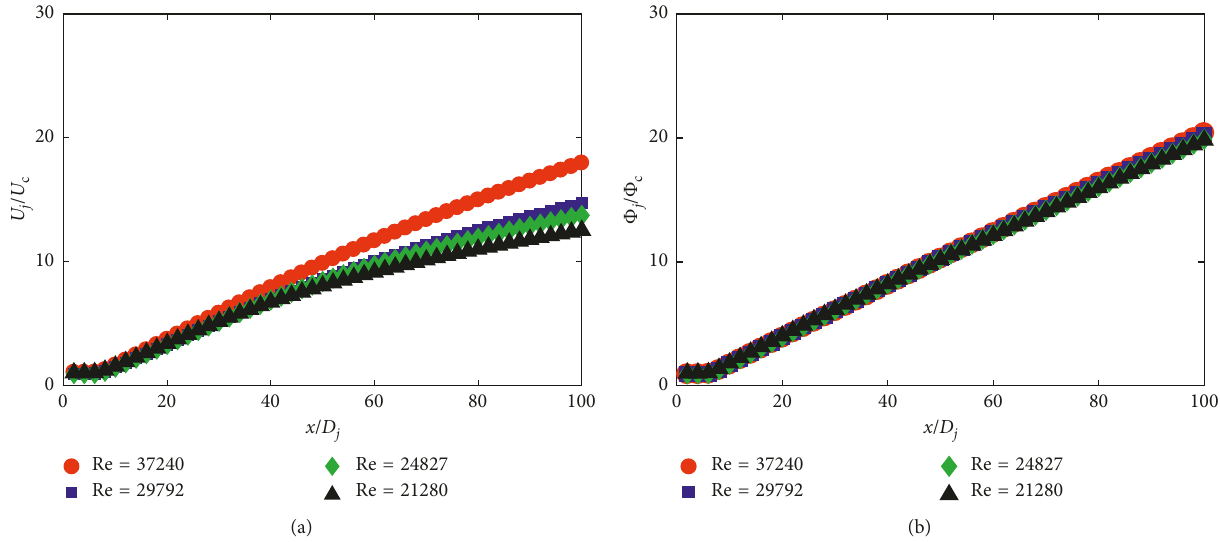
Figure 6: The centerline decay of the mean: (a) streamwise velocity; (b) scalar concentration.